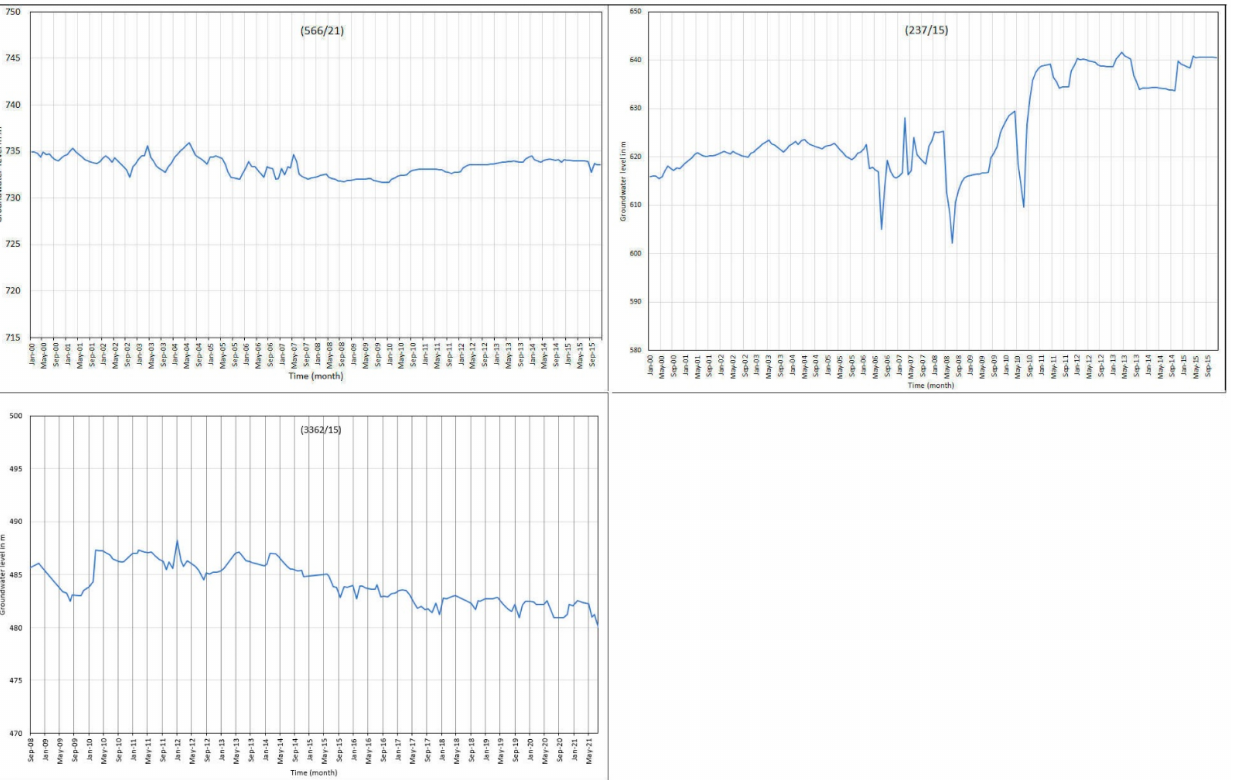
Figure 16. Hydrographs of the groundwater level for three borehole